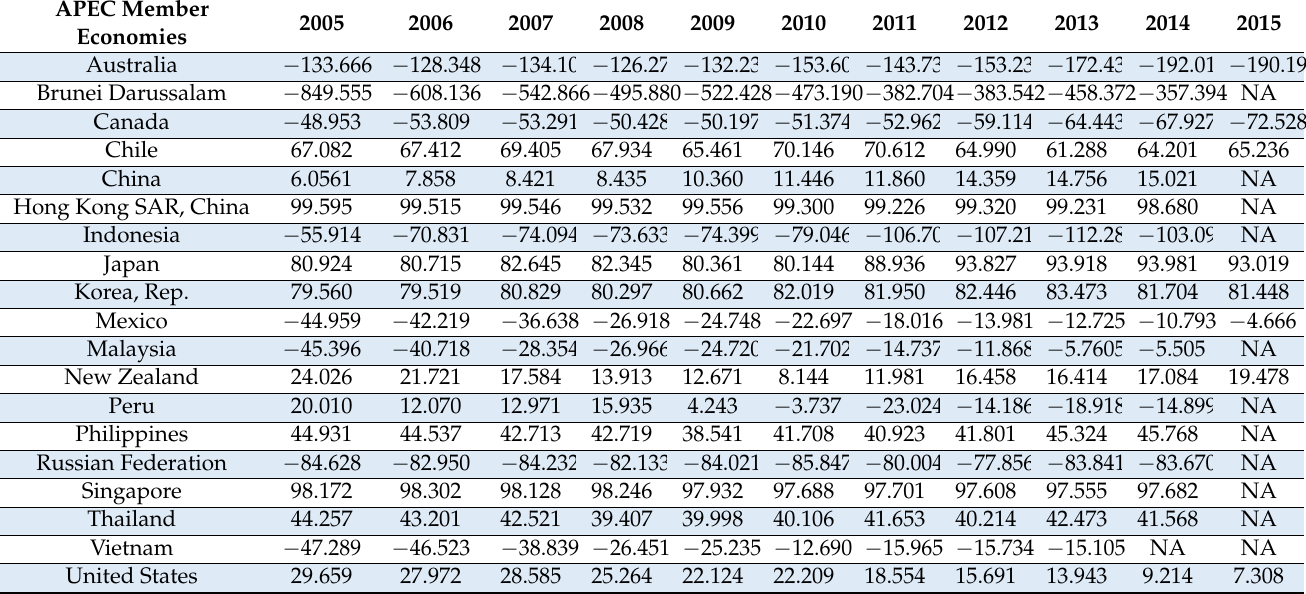
Table A2. Energy imports. net (% of energy use).